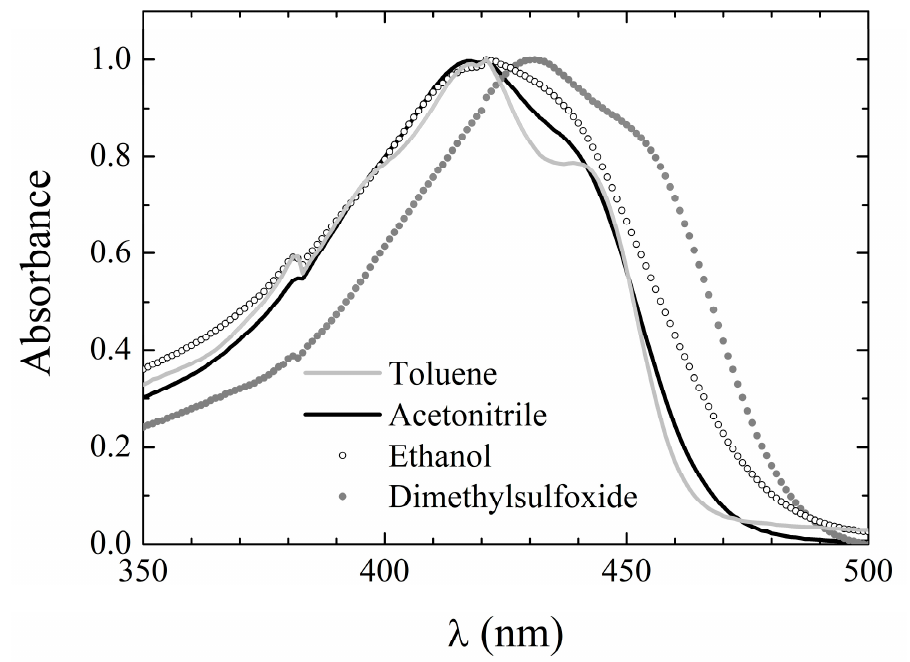
Figure 2. Absorption spectral line shape of 2 in exemplary